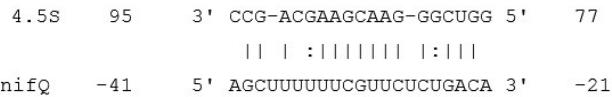
Figure 12. Visualization of the CRISPR locus in the genome of H. seropedicae SmR1. Sense sense in the